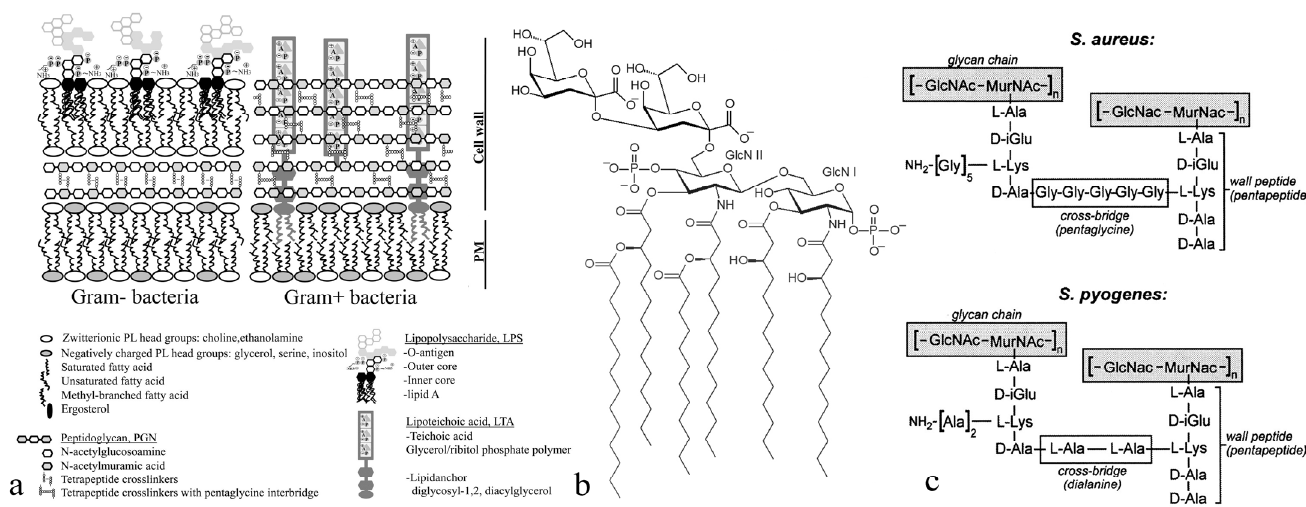
Figure 12. Schematic representation of the cell envelopes of Gram-negative and Gram-positive bacteria ( a ), along with the chemical structures of lipopolysaccharides (LPS, ( b )) and peptidoglycans ( c ) forming them. The chemical structure of peptidoglycans is shown for two Gram-positive bacteria of choice: Staphylococcus aureus and Streptococcus pyogenes . Subfigures ( a – c ) are adapted and modified with permission from Refs. [96–98], respectively.